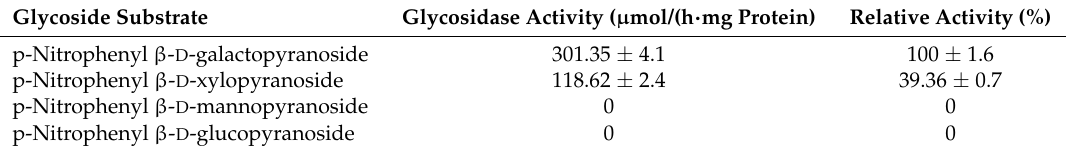
Table 3. Substrate specificity of